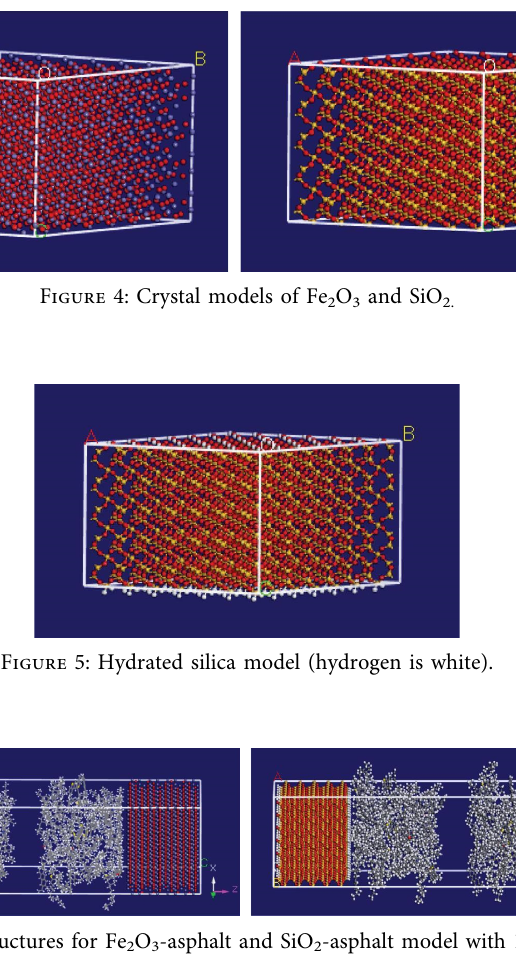
2 O 3 -asphalt and SiO 2 -asphalt model with 10